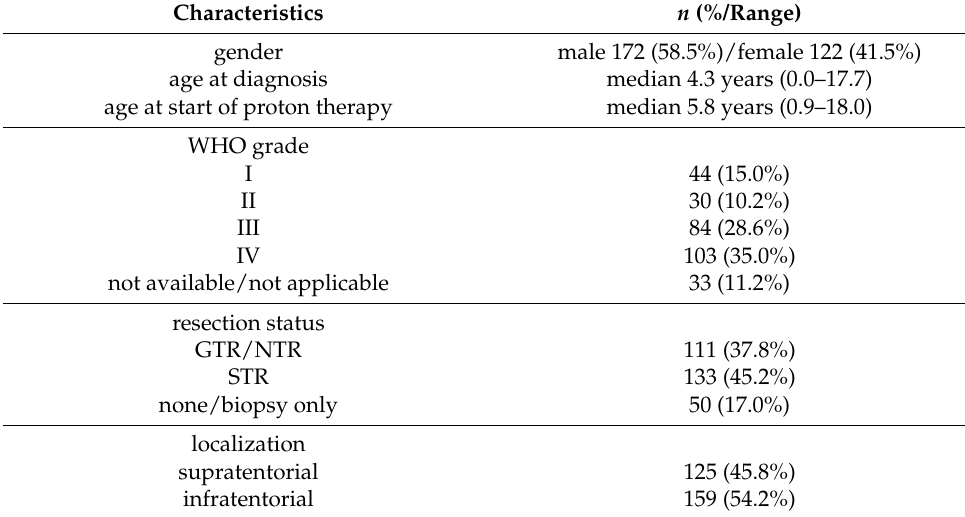
Table 2. Patient characteristics and treatment data ( n =